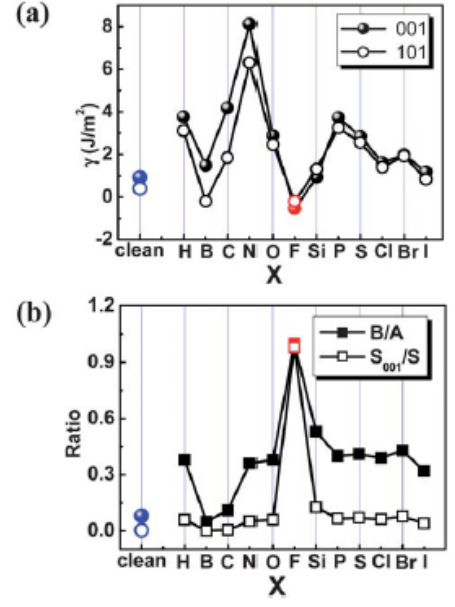
Figure 3. ( a ) Calculated energies of the {001} and {101} surfaces surrounded by X atoms; ( b ) Plots of the optimized B/A value and percentage of {001} facets for anatase single crystals with various adsorbate atoms X. Reprinted with permission from ref.